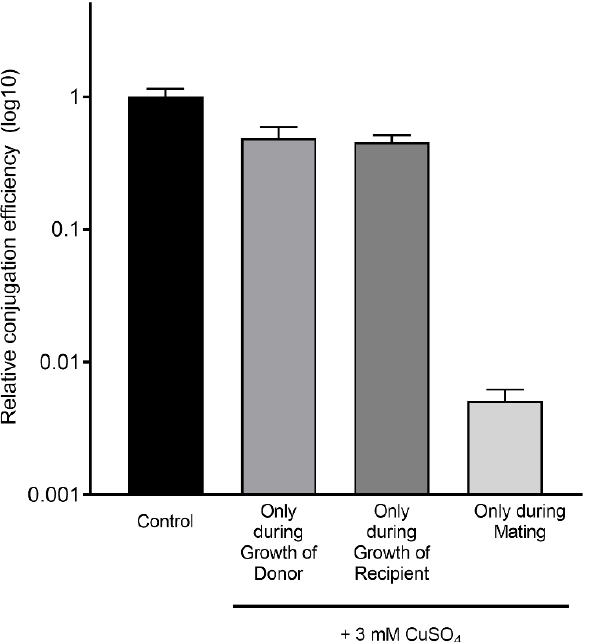
Figure 4. CuSO 4 lowers conjugation efficiency when present during mating. ‘Donor’/’Recipient’: the donor (HA14) or recipient strain (HA4) was grown to log phase while exposed to 3 mM CuSO 4 , after which the culture was pelleted and resuspended in fresh LB, mixed with untreated donor or recipient, and allowed to mate in the absence of CuSO 4 . ‘Mating’: the donor and recipient strains were grown to log phase in the absence of CuSO 4 , and then allowed to mate in the presence of 3 mM CuSO 4 . The bars represent the mean conjugation efficiency relative to the control (0 mM), and the error bars represent the standard error of the mean (SEM) of 2 biological replicates with 2 technical replicates each.